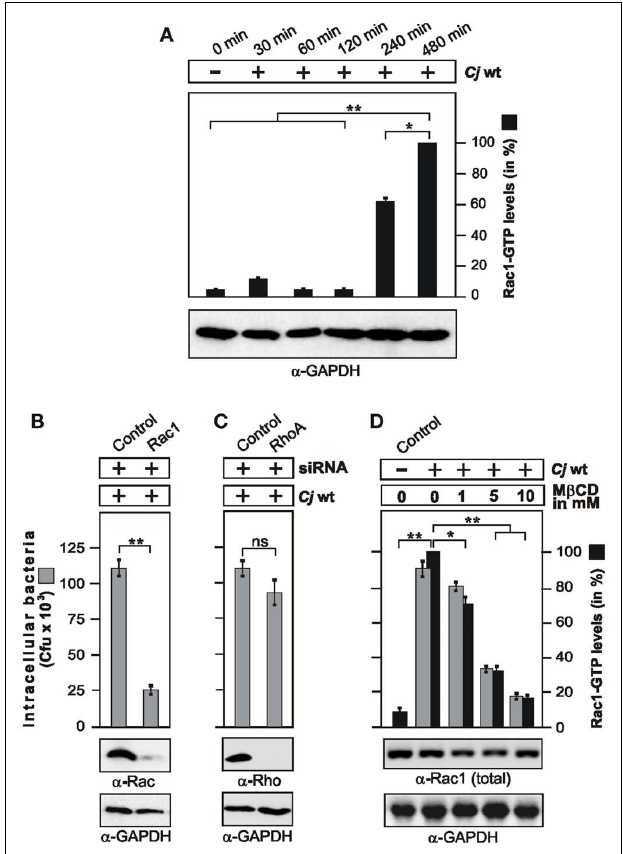
FIGURE 1 | Campylobacter jejuni invasion is time-dependent, and requires Rac1 and lipid rafts. (A) Quantification of Rac1 activity during the course of infection. INT-407 cells were infected withWT C. jejuni 81–176 for indicated periods of time.The presence of active Rac1-GTP was quantified by G-LISA. One hundred percentage of activity corresponds to the highest amount of detected GTPase-GTP level. Similar amount of cells at every time point was confirmed by α -GAPDHWestern blotting. (B,C) Effect of Rac1 and RhoA expression knockdown on C. jejuni invasion. INT-407 cells were transfected with Rac1-siRNA (B) or RhoA-siRNA (C) , as well as a scrambled siRNA as control. After 48h, cells were infected with C. jejuni for 6h. Intracellular bacteria were quantified by gentamicin protection assays. Immunoblotting with α -Rac1 or α -RhoA antibodies confirmed down-regulation of the proteins. GAPDH expression levels were determined as control. (D) Effects of M β CD targeting lipid rafts on host cell internalization of C. jejuni . INT-407 monolayers were pre-incubated with the indicated concentrations of M β CD for 30min, followed by 6h infection with C. jejuni .Total intracellular C. jejuni were quantified by gentamicin protection assays.The presence of active Rac1-GTP was analyzed by CRIB–GST pull-down and quantified. One hundred percentage of activity corresponds to the highest amount of detected GTPase-GTP level (right lane). Similar quantities of total Rac1 and GAPDH were confirmed by Western blotting. ∗ p < 0.05 and ∗∗ p ≤ 0.005 were considered as statistically significant as compared to the